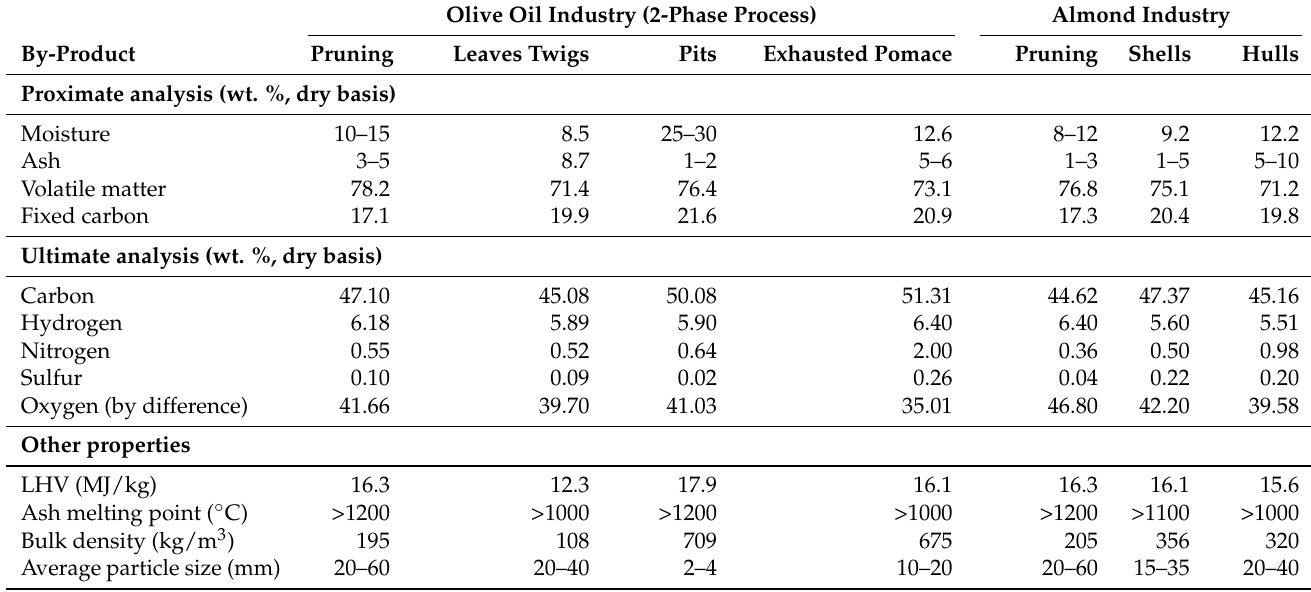
Table 5. Proximate, ultimate analysis and other properties of olive oil and almond industry